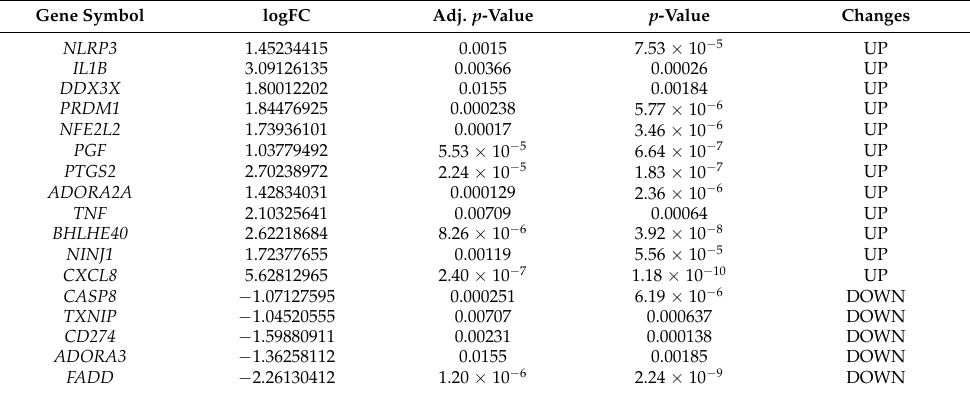
Figure 1. Identification of differentially expressed genes in gout. ( A ) Volcano map of differentially expressed genes associated with gout; ( B ) Heatmap demonstrating the top 30 upregulated and downregulated genes; ( C ) Venn diagram demonstrating the intersection between gout and pyroptosis- related differentially expressed genes; ( D ) Heatmap of 17 pyroptosis-related differentially expressed genes associated with gout. Table 2. 17 Data on the differential genes associated with gout and